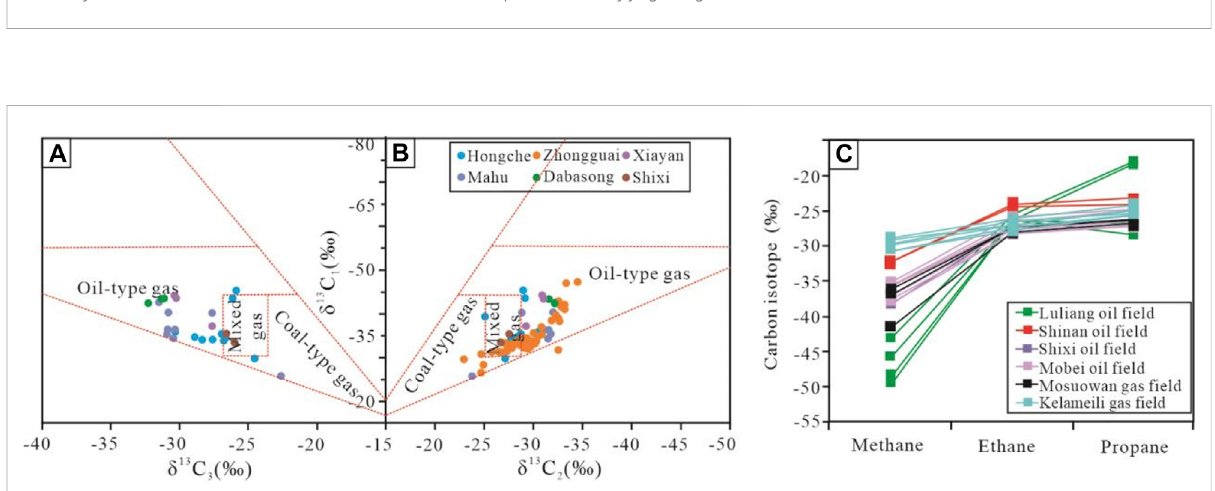
FIGURE 5 (A) Carbon isotopic compositions of propane ( δ 13 C 3 ) and (B) carbon isotopic compositions of ethane ( δ 13 C 2 ) versus carbon isotopic compositions of methane ( δ 13 C 1 ) in Carboniferous and Permian reservoirs in the Penyijingxi Sag; (C) Carbon isotopic compositions of natural gas in Carboniferous and Permian reservoirs in the Penyijingxi